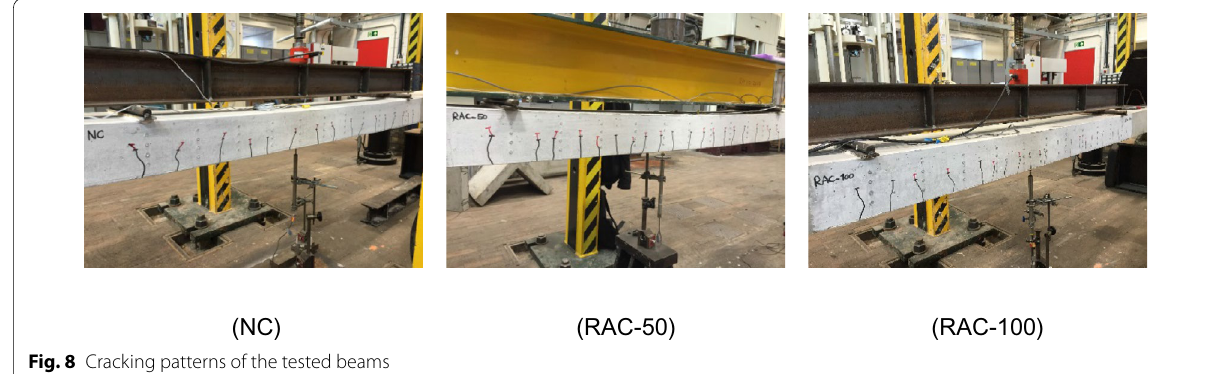
Fig. 8 Cracking patterns of the tested beams